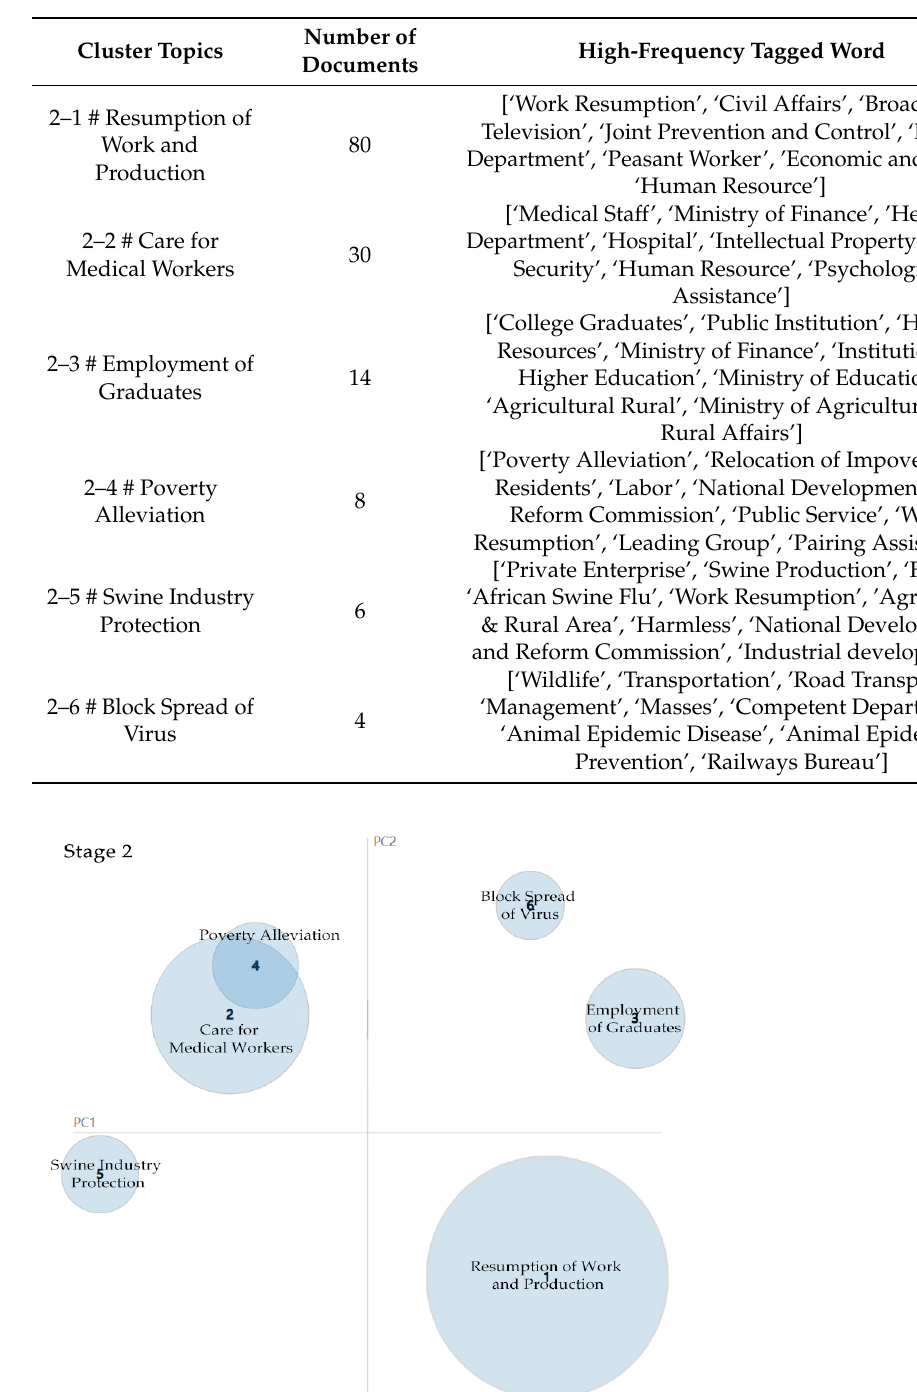
Table 2. Topic contents in Stage 2.